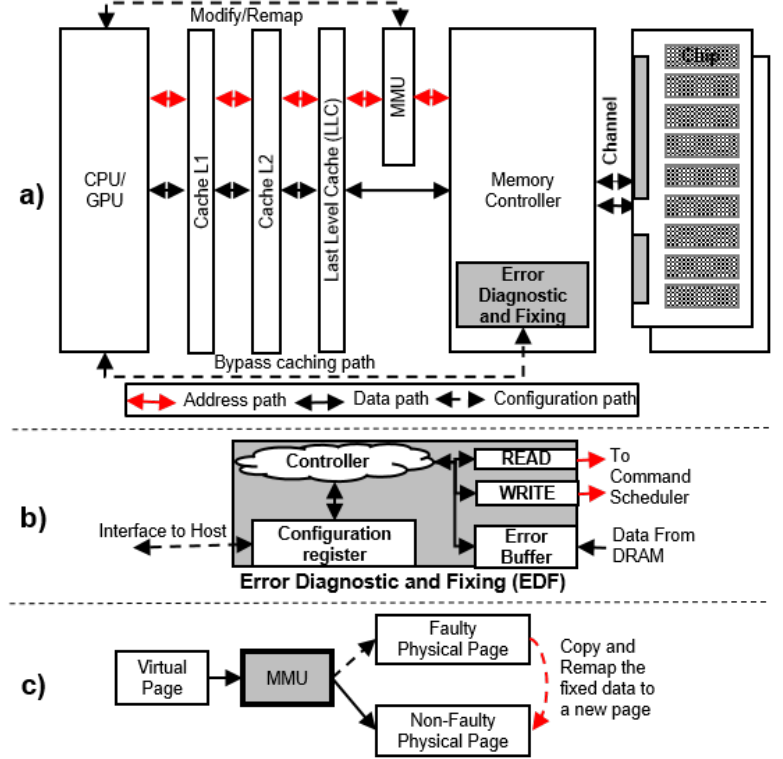
Figure 4. A description of the memory fault management architecture: ( a ) the overall data and control flow in the memory fault management architecture, ( b ) the details of the EDF module, and ( c ) the remapping flow for faulty